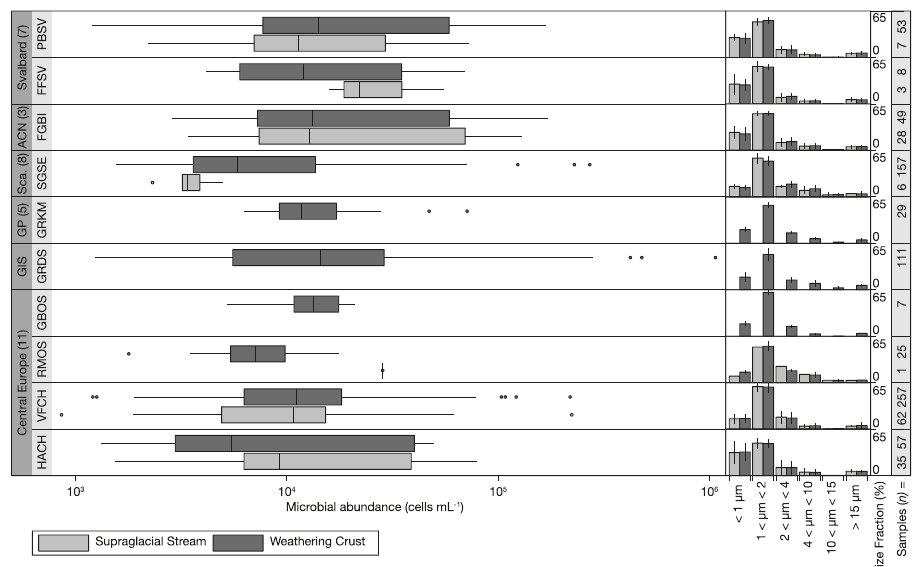
Fig. 3 Cell concentration and size distributions within the weathering crust and supraglacial streams at each investigated glacier. All distributions are box and whisker plots displaying median, 25 to 75 percentiles, distribution range and outlying sample measurements (as grey dots) for each glacier in latitudinal order (from north to south). Each site is coded by RGI region (ACN: Arctic Canada North; Sca.: Scandinavia; GP: Greenland Periphery and GIS: Greenland Ice Sheet; and glacier identi fi er (listed in Fig. 2). Sample numbers ( n ) correspond to the abundance box plots with which they vertically